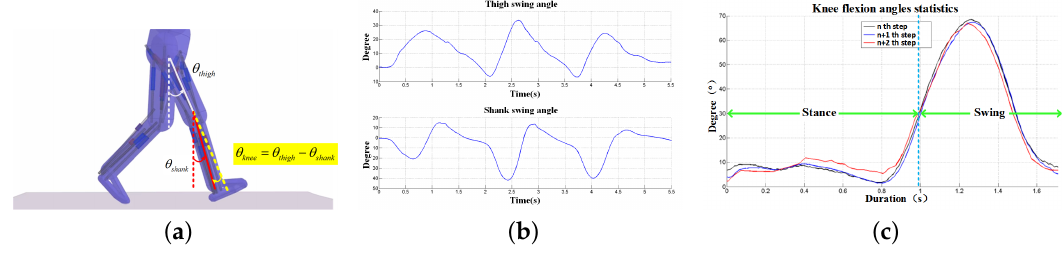
Figure 4. Knee angle estimation results ( a ) calculation principle of knee; ( b ) swing angle of thigh and shank; ( c ) knee flexion flexion statistics.